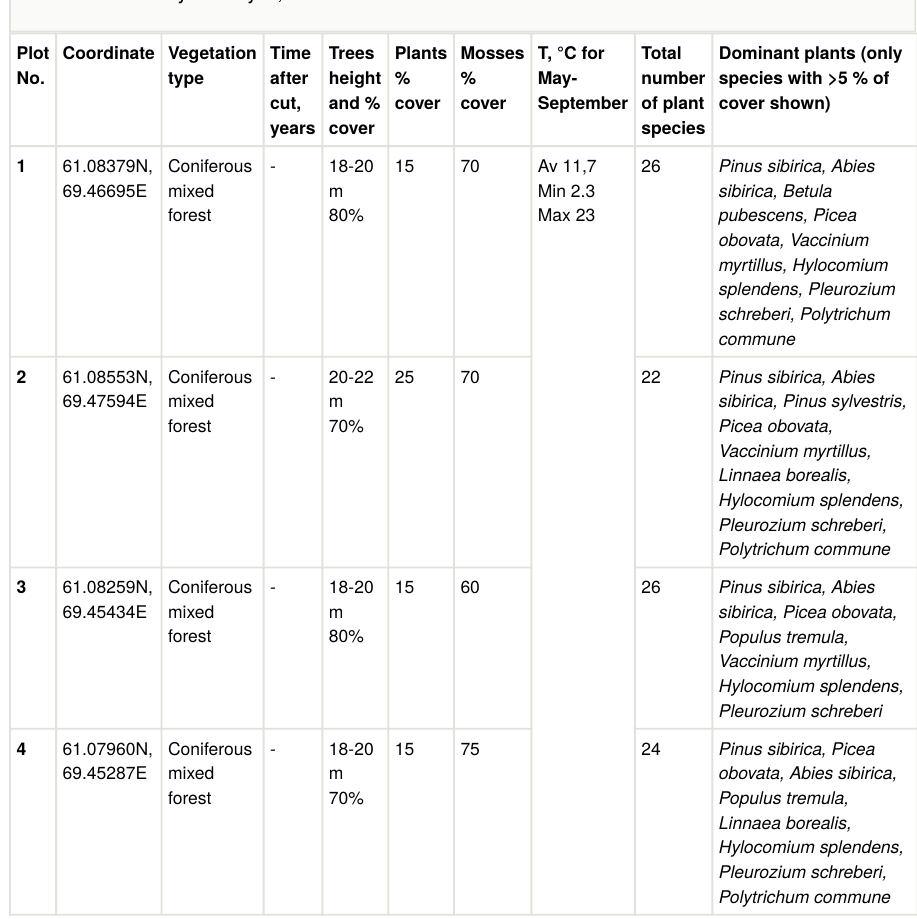
Dominant plants (only species with >5 % of cover shown)